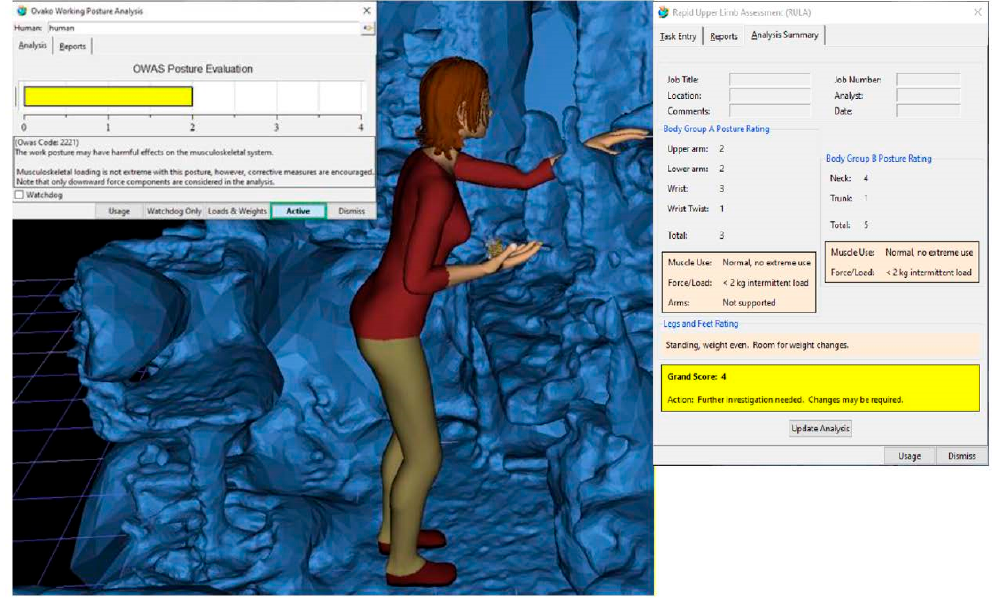
Figure 9. Worker’s position during work with OWAS and rapid upper limb assessment (RULA) analyses results.